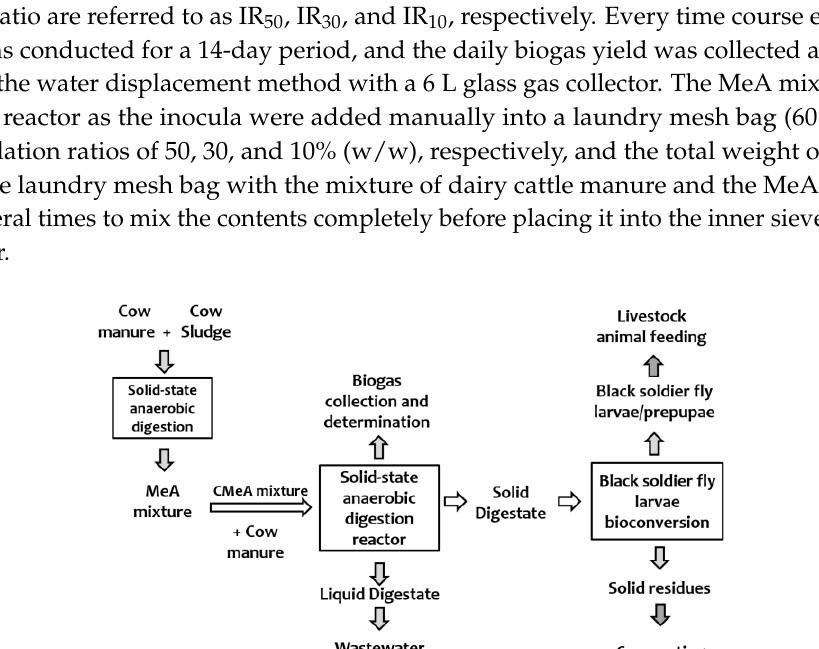
Figure 2. Flow chart of the two-step biological treatment system.